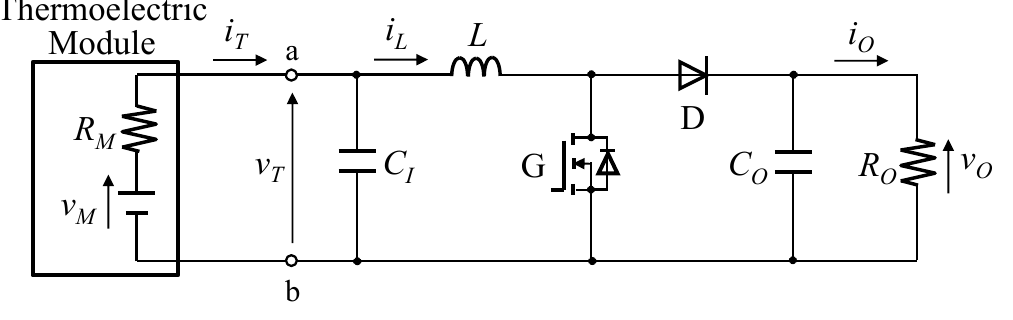
Figure 3. System configuration of the thermoelectric power generation system using a boost